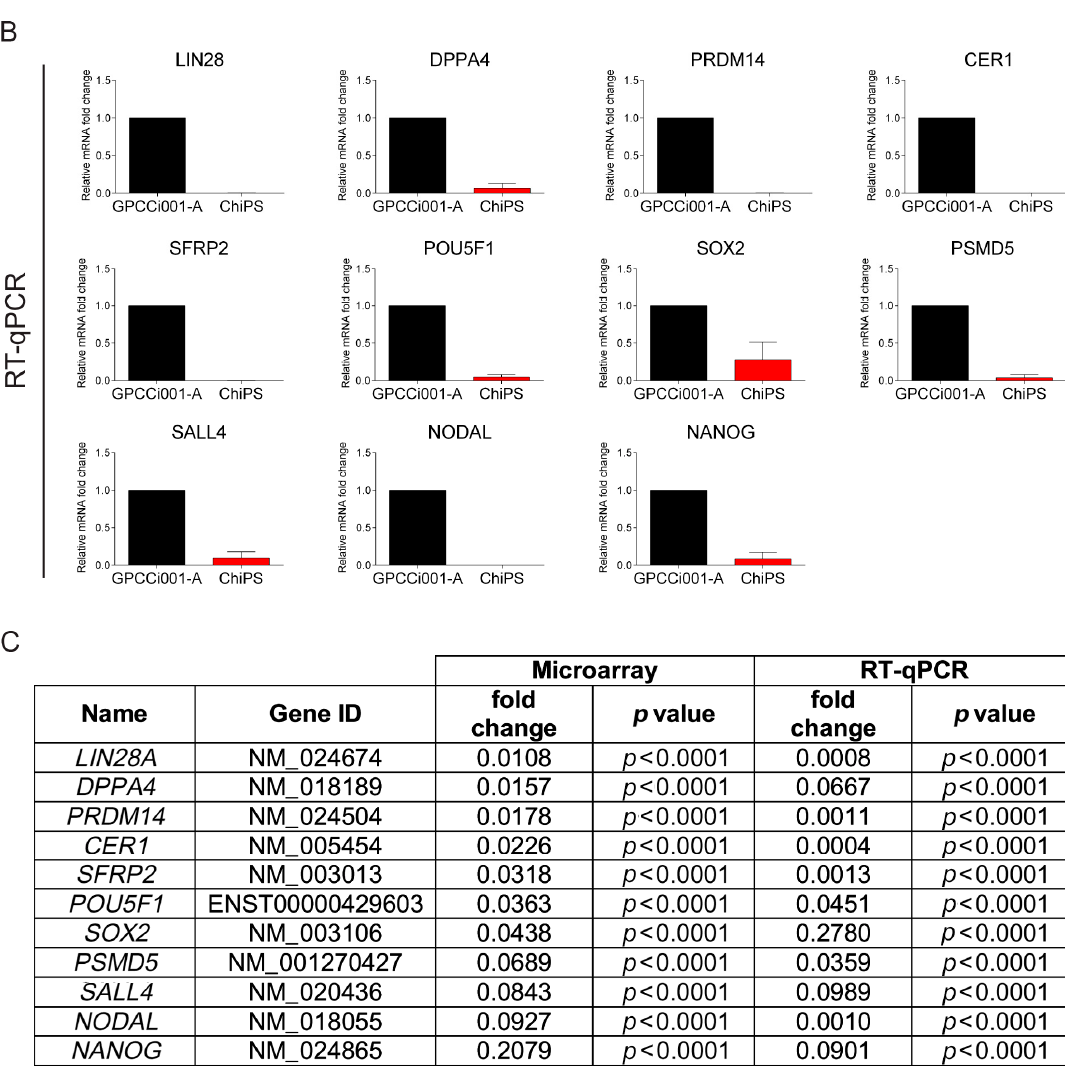
Figure 6. Real time qPCR validation of microarray data. For validation, we selected the most highly expressed genes according to the Circos plot GO terms. The top panel represents normalized GPCCi001-A cell line fold changes of selected genes based on microarray data ( A ). The bottom panel represents microarray data validated by RT-qPCR. The graph represents means ± SD from three independent experiments ( B ). The table representing normalized to GPCCi001-A fold changes and p -values of selected genes from microarray and RT-qPCR analysis ( C ).